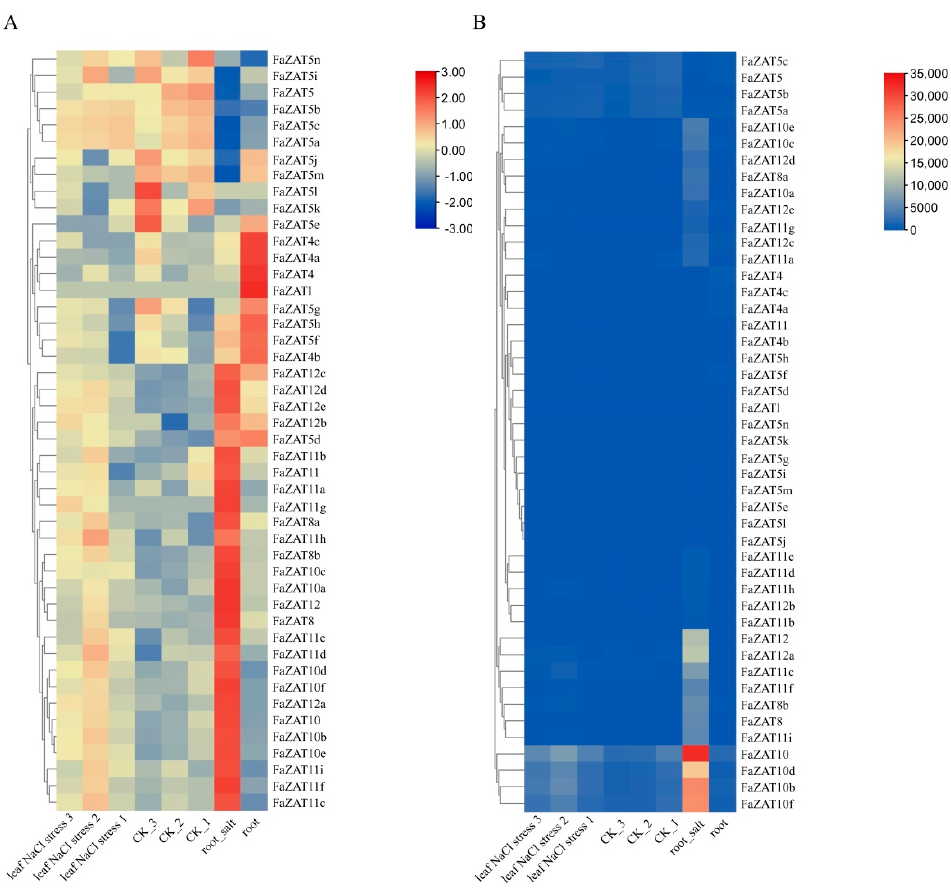
Figure 7. Transcript abundance of the C2H2-ZFP C1-2i subclass under salt stress. NaCl stress: 100 mM NaCl for 12 h; numbers indicate three biological replicates. The heatmap represents log2 value of FPKM. ( A ) The FPKM of each row was normalized. ( B ) The FPKM was not normalized.